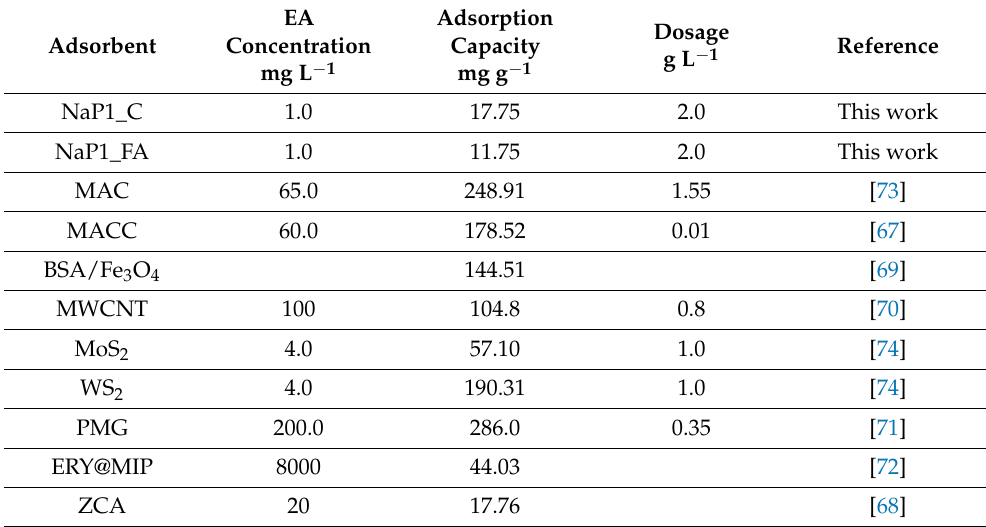
Table 5. Comparison of the adsorption capacities of different adsorbents in reaction with ery-